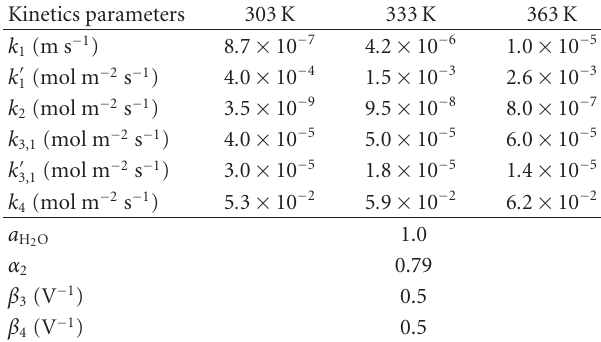
Table 1: Kinetics parameters for modeling [7]. Kinetics